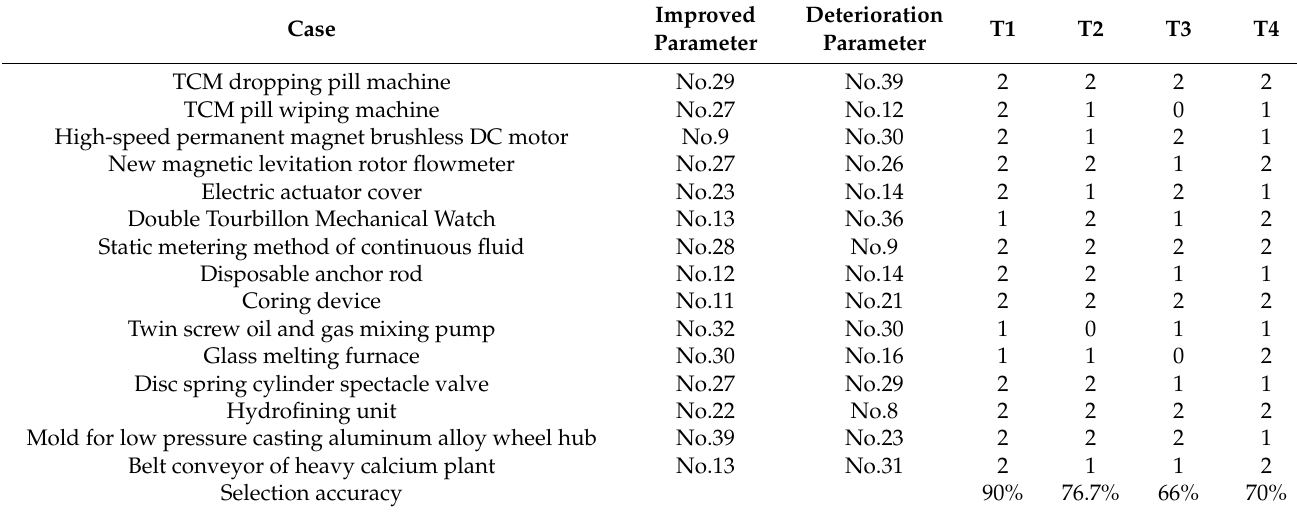
Table 15. Results of case